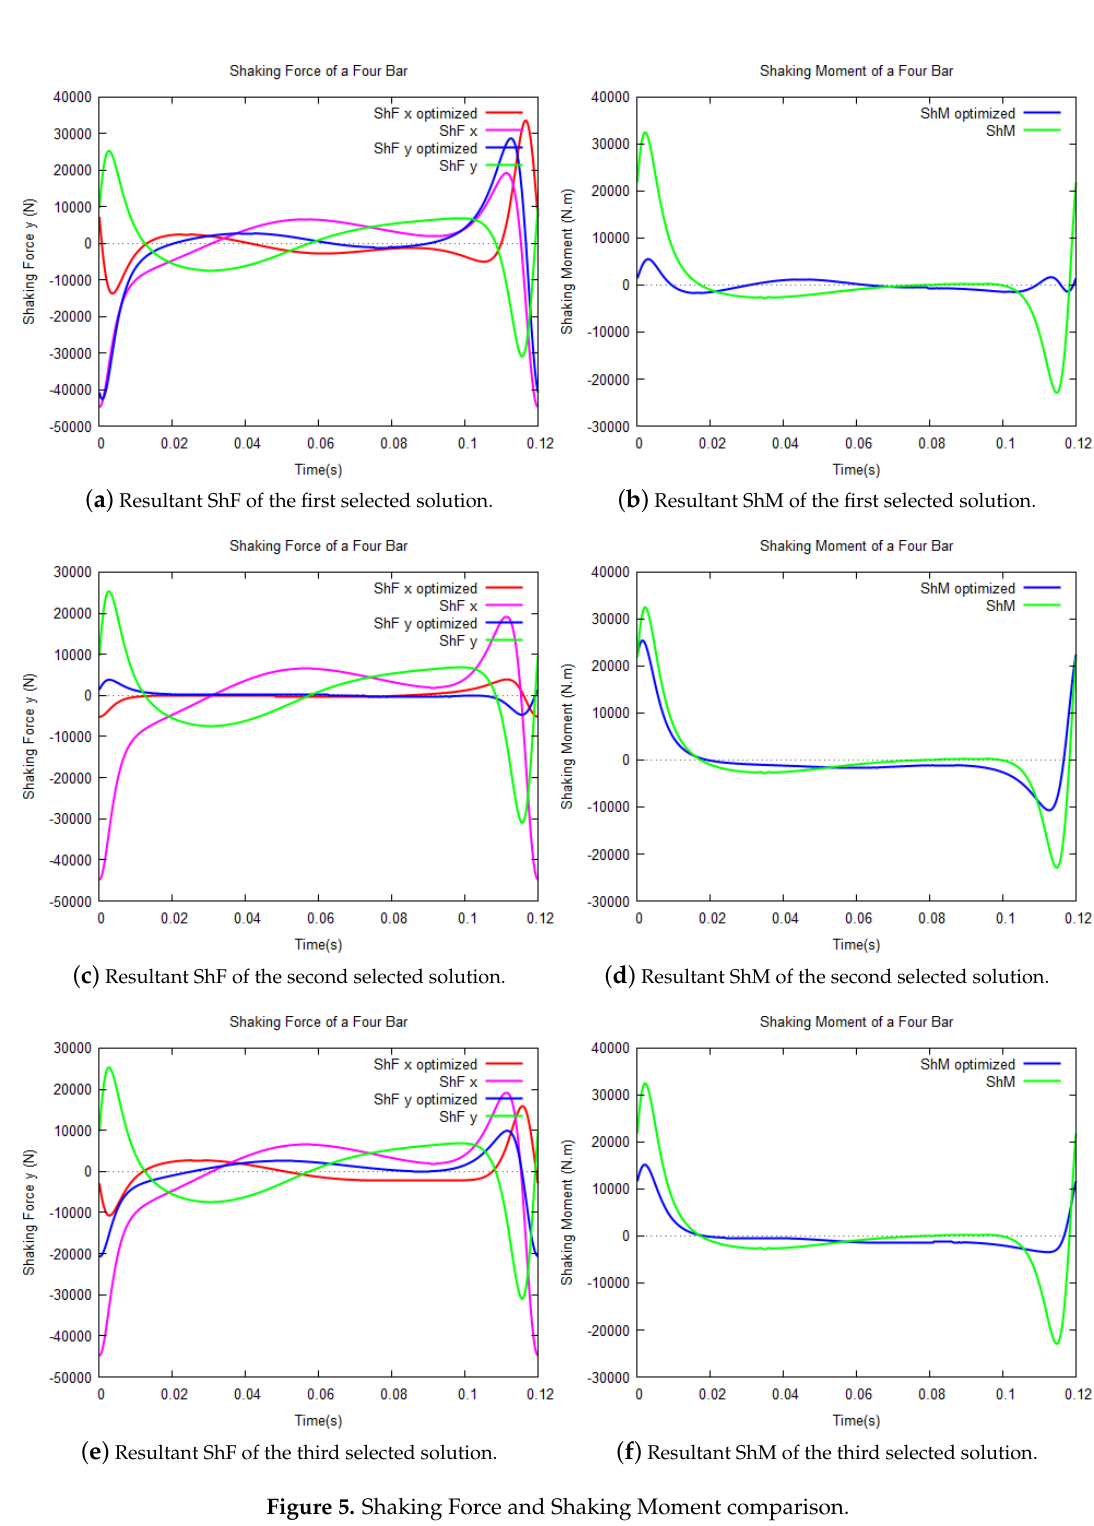
Figure 5. Shaking Force and Shaking Moment